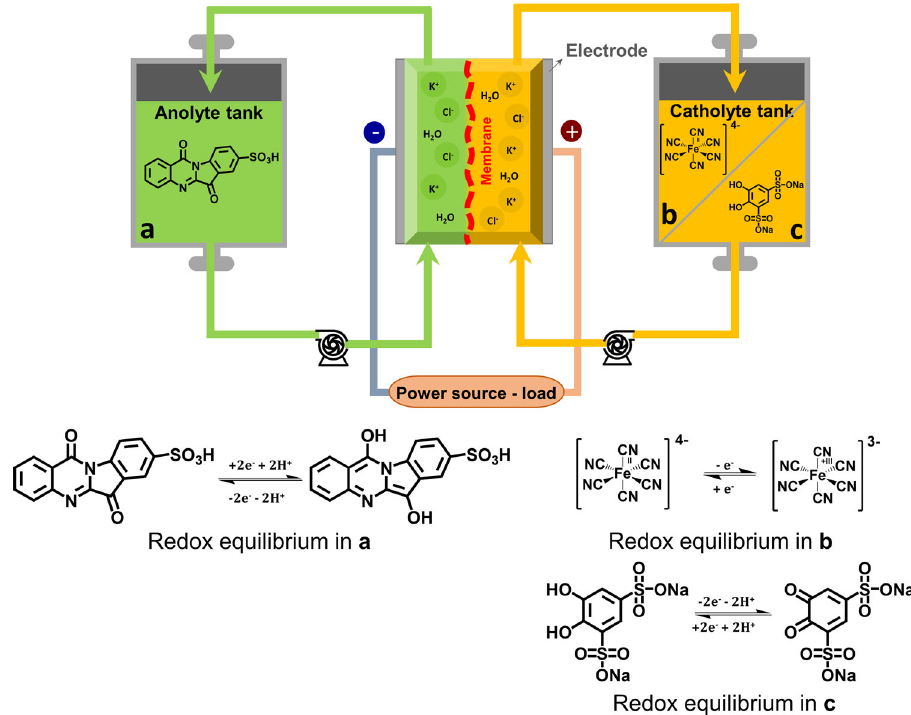
Fig. 4 Schematic illustration of RFBs cell tests. Aqueous organometallic and all-organic RFB cell using TRYP-SO 3 H and K 4 [Fe(CN) 6 ]/BQDS redox couples in neutral pH, and redox reaction mechanisms of TRYP-SO 3 H ( a ), K 4 [Fe(CN) 6 ] ( b ), and BQDS ( c ).